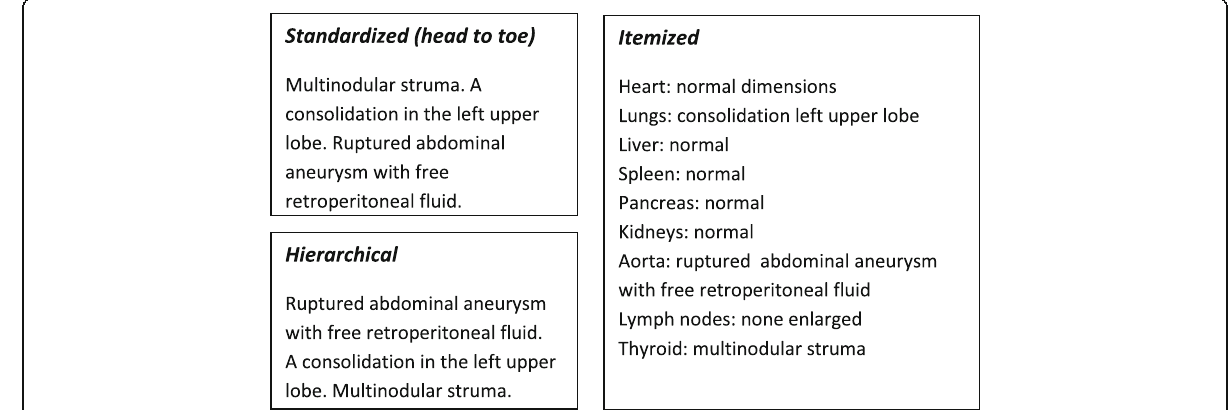
Fig. 1 Structured reporting level 1: Structured layout. Examples of structured layout. Standardized reports use a standardized order (free text); in